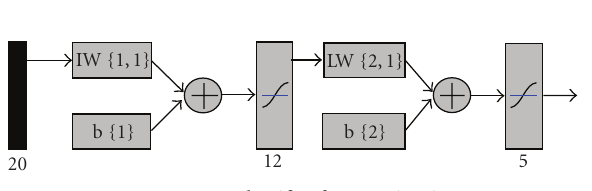
Figure 7: Classifier for test circuit.